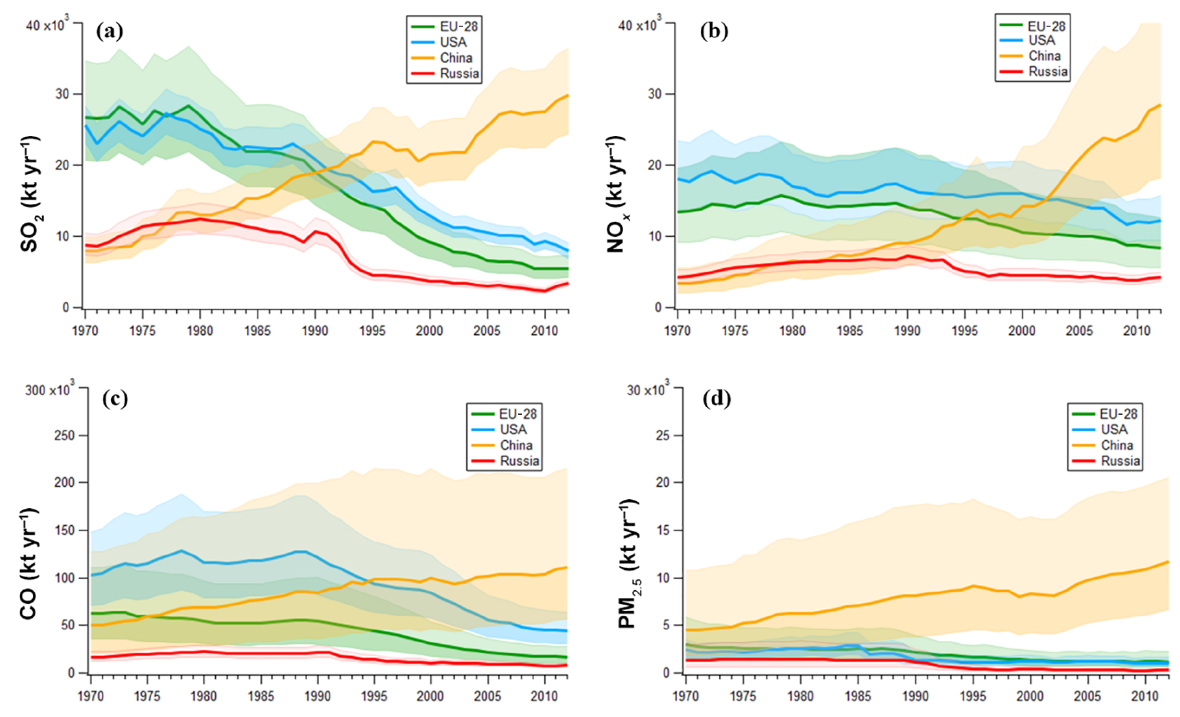
Figure 6. Emission time series of SO 2 , NO x , CO, and PM 2 . 5 with uncertainty bands for top emitting countries or regions (China, the USA, Russia, and